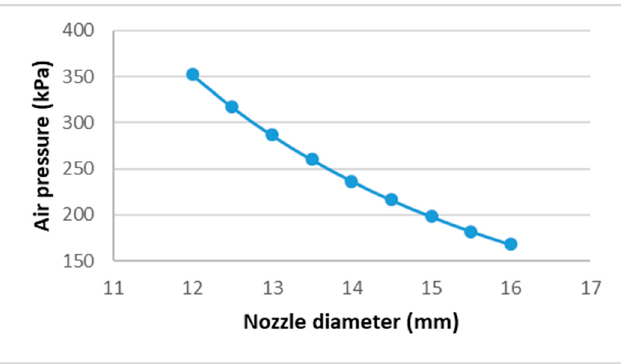
Figure 1. The shape of a nozzle diameter [19].